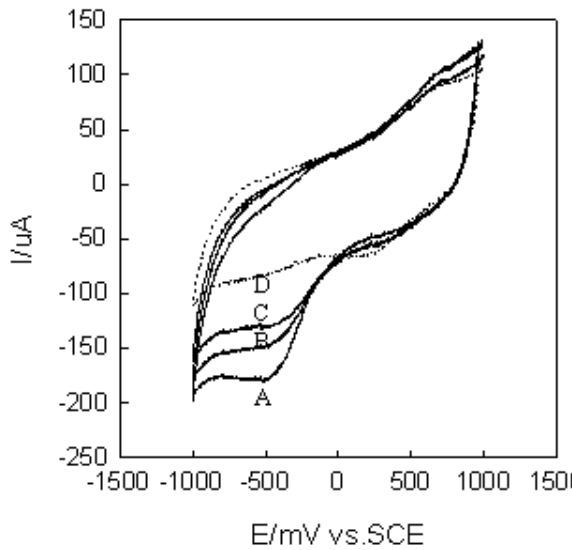
Figure 2. Cyclic voltammograms obtained with a MnT( o -glu)TTCl-modified electrode after incubation in MTZ solutions of concentration (A): 5×10 -4 M/L, (B): 1×10 -5 M/L, (C): 5 × 10 -7 M/L, and a unmodified one incubated in 5 × 10 -4 M/L MTZ (D).